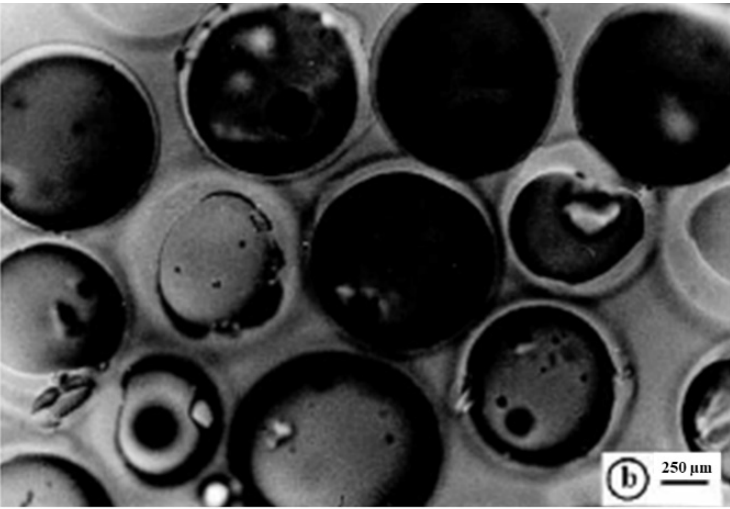
Figure 5. Optical microphotographs of the swollen R4 (letter b indicates the scale bar). Figure 6 shows the appearance of the soaked R4 (SR4) obtained in the previous experiment (a) and the fully dried R4 (DR4) obtained by heating SR4 at 37 ◦ C for 6.5 h.